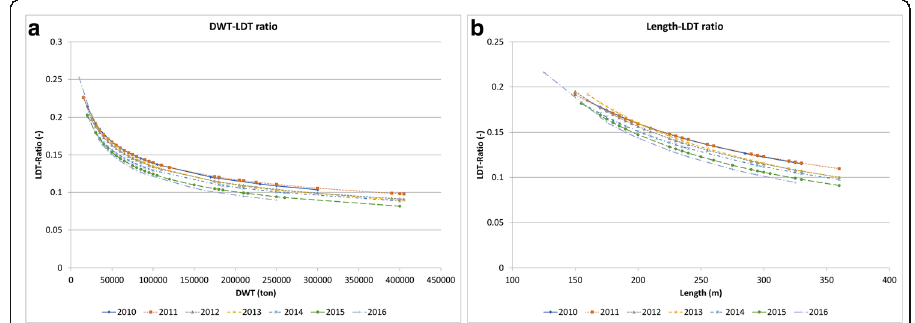
Fig. 4 OLS estimated lines for LDT ratio based on DWT (left) and Length (right)